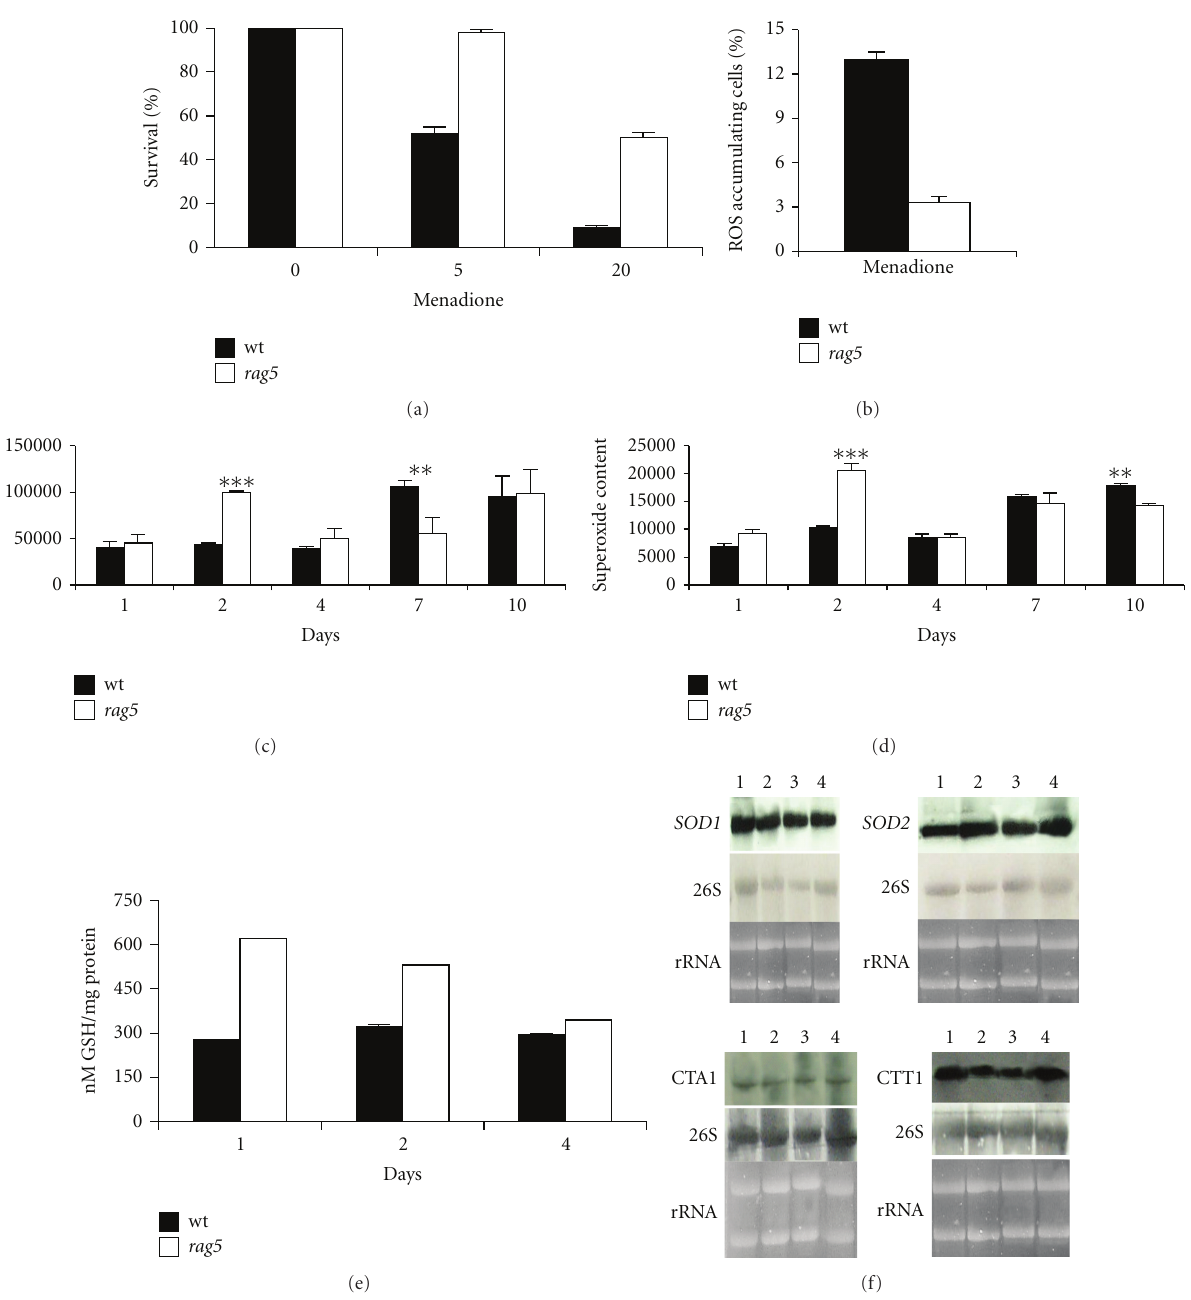
Figure 3: Oxidative stress analysis in rag5 Δ strain. (a) Evaluation of stress resistance of the long-lived strain by inducing ROS damage with 5 and 20 μ M menadione. (b) Evaluation of ROS accumulation in 1 day cultures of wt and rag5 cells challenged with 20 μ M menadione for 2 hours. The results were the mean of at least three independent experiments with s.d. < 5%. (c, d) Measurement of cellular ROS. FACS analysis of aging cells stained for cellular ROS using DHR123 (c) and cellular superoxide using DHE (d) are shown. The mean fluorescent intensity of three independent experiments is plotted ± one standard deviation. ∗∗ P value from a Student’s t -test, < 0.01, ∗∗∗ P value from a student’s t -test, < 0.001. (e) Total glutathione levels. GSH levels were normalized with respect to the protein total content of the samples. The results are the mean of three independent experiments with s.d. < 5%. (f) Northern analysis of CTA1 , CTT1 , SOD1, and SOD2 in wt strain and in rag5 Δ strain. Total mRNAs were prepared as described in Section 2 from cells grown on YPD medium for 24 and 48 hours. Lines 1: wt, 24 h; line 2: rag5 Δ , 24h; lines 3: wt, 48h; line 4: rag5 Δ , 48 h. The experiment showed is representative of three independent experiments, repeated with similar